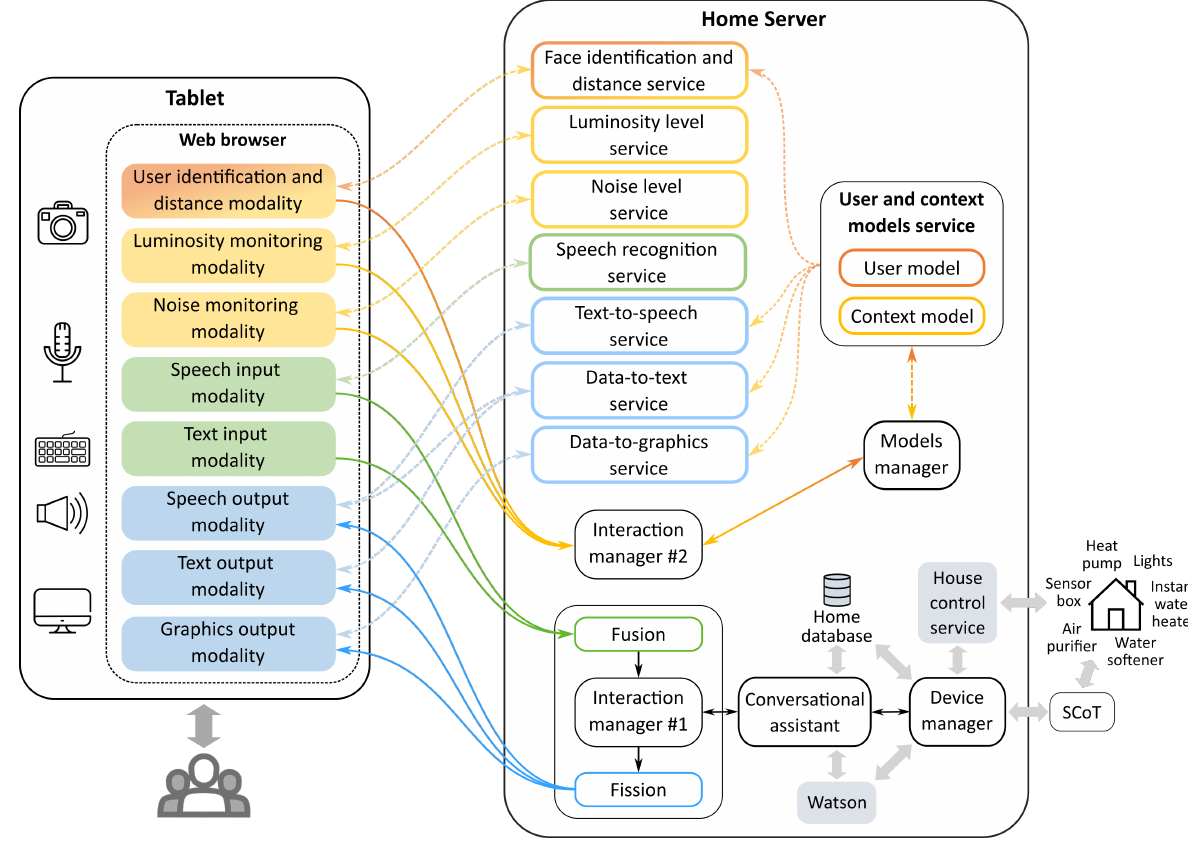
Figure 2. Architecture of the home assistant, including all the components that enable multimodal adaptive interaction with a smart